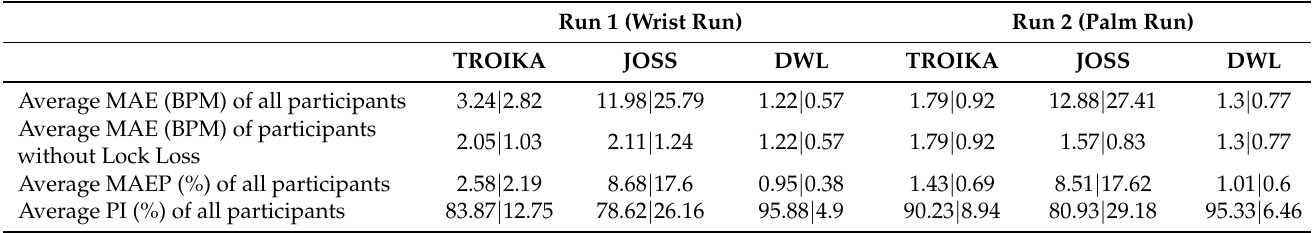
Table 6. Summary of performance metrics for run 1 (wrist run) and run 2 (validation palm run). For run 1, we showed the average performance of eleven (11) participants. For run 2, we showed the average performance of twelve (12) participants. Results are represented as “mean | standard deviation”. Run 1 (Wrist Run) Run 2 (Palm